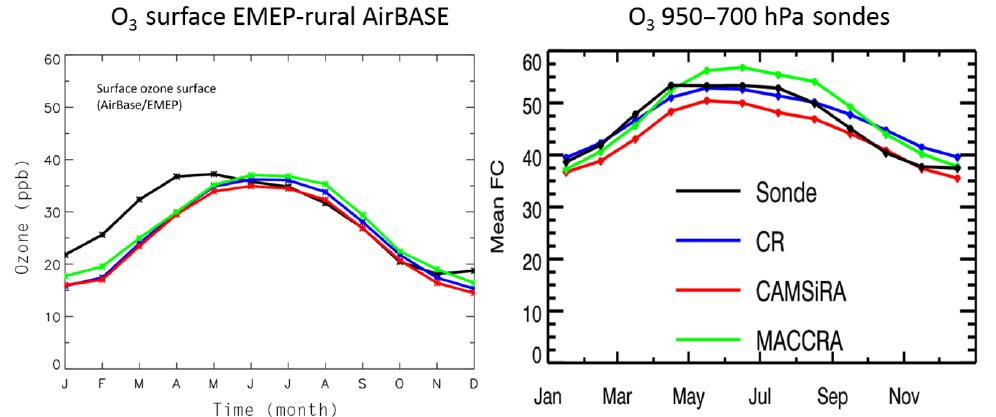
Figure 24. Average seasonal cycle of surface ozone at EMEP AirBase stations (left) and at European ozone sonde sites in the pressure range (950–700hPa) for CAMSiRA (red), the CR (blue) and MACCRA